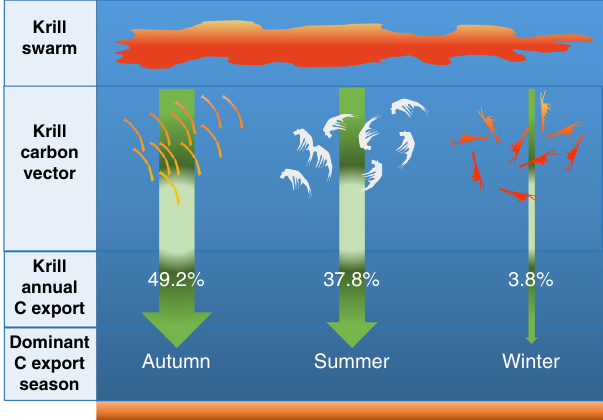
Fig. 2 Dominant processes driving krill carbon fl ux. Schematic showing the average annual proportional contribution (%) of krill derived carbon (faecal pellets, exuviae and carcasses respectively) to annual particulate organic carbon (POC) fl ux and the dominant export season for